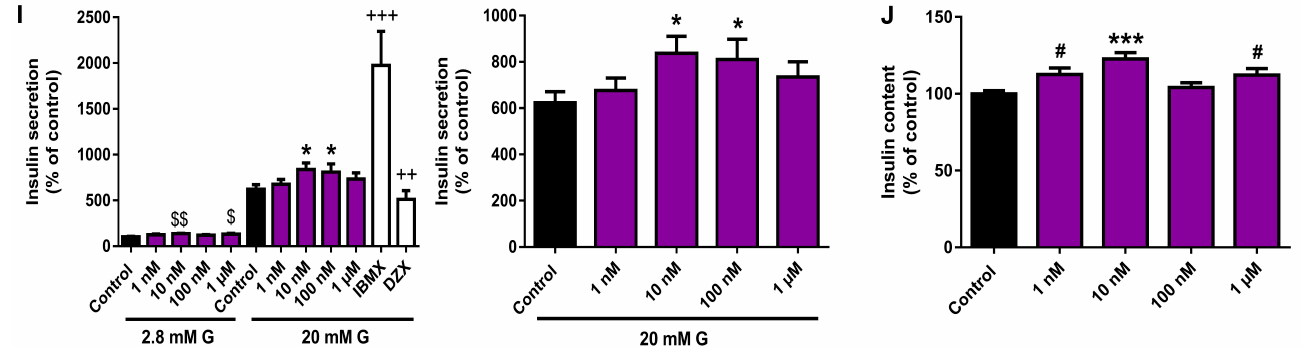
Figure 4. PFOS effects on pancreatic β -cells. ( A ) Viability of MIN6 cells treated for 24 h with different PFOS concentrations (100 pM–10 µ M) as evaluated by RZ, NRU and CFDA-AM assays. n = four independent experiments. * vs. Control; one-way ANOVA or Kruskal-Wallis. ( B ) mRNA expression of Ins , Pdx1 , Hnf4 α , MafA , Kir6.2 , Sur1 , Glut2 , and Gck in MIN6 cells treated for 24 h with different PFOS concentrations (100 pM–10 µ M). n = three independent experiments. * vs. Control; one-way ANOVA. #vs. Control; Student’s t -test. ( C ) Effects of PFOS (100 pM–10 µ M) on GSIS in MIN6 cells treated for 24 h. n =five independent experiments. * vs. Control 16.7 mM G; two-way ANOVA. + vs. Control 16.7 mM G; one-way ANOVA. ( D ) MIN6 insulin content after 24 h PFOS treatment. n = five independent experiments. * vs. Control; Kruskal-Wallis. ( E ) Viability of EndoC- β H1 cells treated for 72 h with different PFOS concentrations (1 nM–1 µ M) as evaluated by RZ, NRU and CFDA-AM assays. n = five independent experiments. * vs. Control; Kruskal-Wallis. ( F ) mRNA expression of INS , PDX1 , HNF4 α , MAFA , MAFB , KIR6.2 , SUR1 , SNAP25 , GLUT1, and GCK in EndoC- β H1 cells treated for 72 h with different PFOS concentrations (1 nM–100 nM). n = three independent experiments. ( G ) Upper panel, representative recordings of K + currents in response to depolarizing voltage pulses in Control or PFOS (1 nM–100 nM) EndoC- β H1 treated-cells for 72 h. Lower panel, relationship between K + current density and the voltage of the pulses. Control ( n = 11) and PFOS ( n = 11–14 per condition) cells. * Control vs. 10 nM PFOS; two-way ANOVA. ( H ) Upper panel, representative recordings of Ca 2+ currents in response to depolarizing voltage pulses in Control or PFOS (1 nM–100 nM) EndoC- β H1 treated-cells for 72 h. Lower panel, relationship between Ca 2+ current density and the voltage of the pulses. Control ( n = 10) and PFOS ( n = 10–12 per condition) cells. * Control vs. 10 nM PFOS and # Control vs. 100 nM PFOS; two-way ANOVA. ( I ) Effects of PFOS (1 nM–1 µ M) on GSIS in EndoC- β H1 cells treated for 72 h. Left panel: GSIS in response to low glucose (2.8 mM G) and high glucose (20 mM G). Right panel is an inset graph that shows insulin release in response to 20 mM G. n = five independent experiments. * vs. Control 20 mM G; two-way ANOVA. $ vs. Control 2.8 mM G and + vs. Control 20 mM G; Kruskal-Wallis. ( J ) EndoC- β H1 insulin content after 72 h PFOS treatment. n = five independent experiments. * vs. Control; Kruskal-Wallis. # vs. Control; Student’s t -test. All data are expressed as mean ± SEM. Significance * p < 0.05, ** p < 0.01, *** p < 0.001, and **** p < 0.0001; # p < 0.05, ## p < 0.01, ### p < 0.001, and #### p < 0.0001; $ p < 0.05, and $$ p < 0.01; + p < 0.05, ++ p < 0.01, and +++ p <